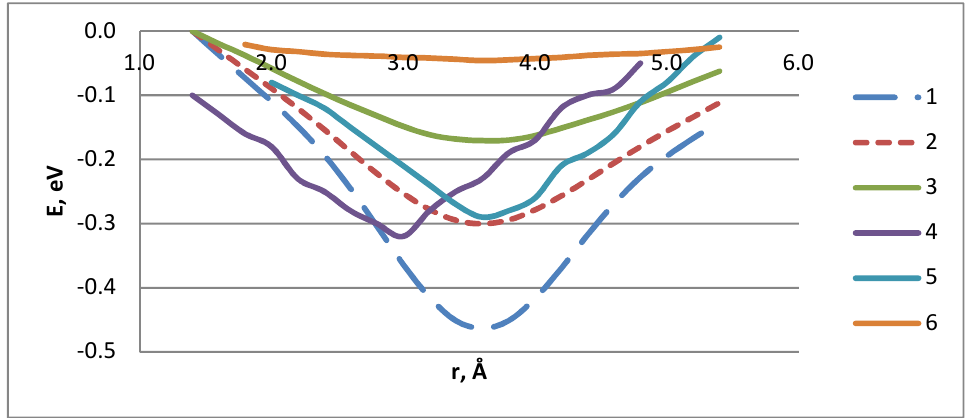
Figure 4. A scan of an arbitrary site on the surface modified carbon nanotube (6,0) that contain a Li atom (a pink color ball of a larger size); the dotted line indicates the route of Li atom movement in relation to an amino group functionally modified nanotube.